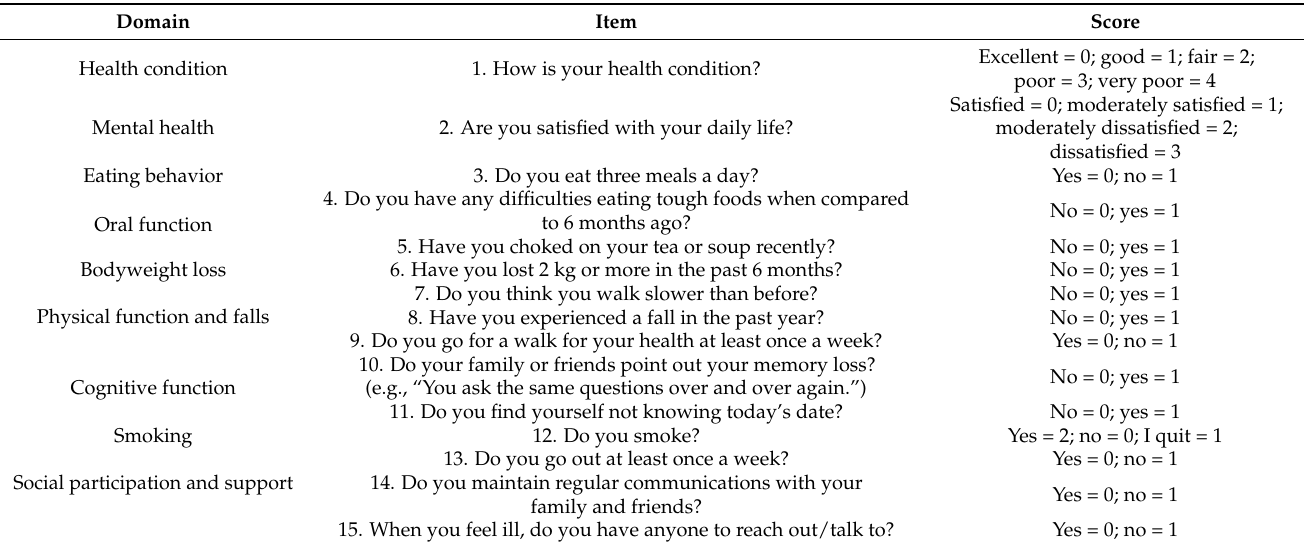
Table 1. The health assessment questionnaire for old-old